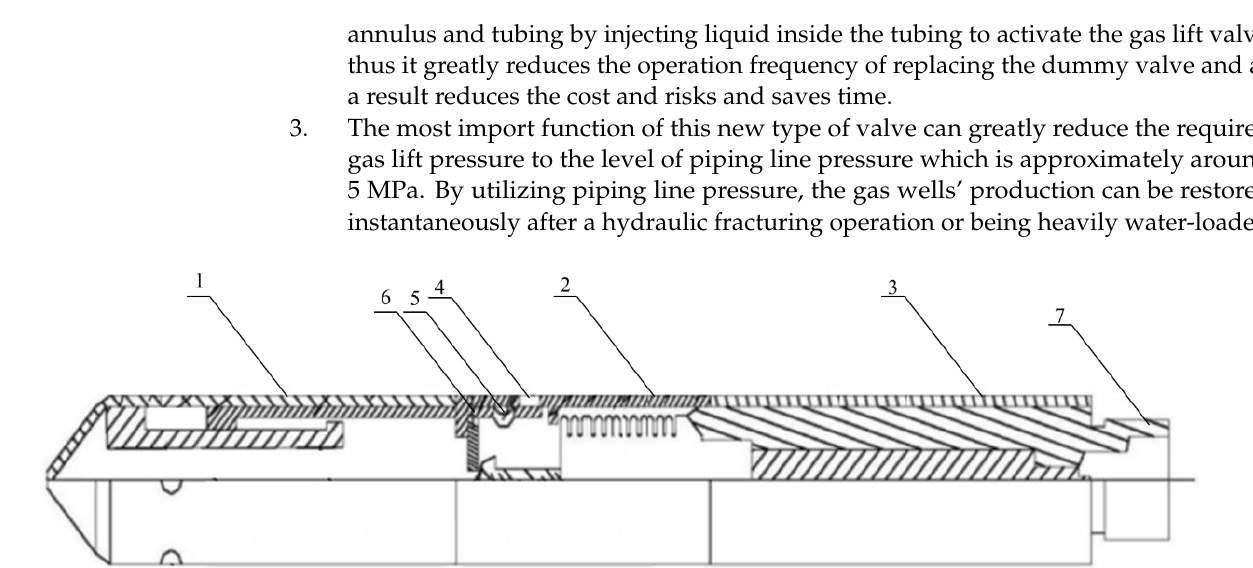
Figure 4. New type of fixed gas lift valve structure.